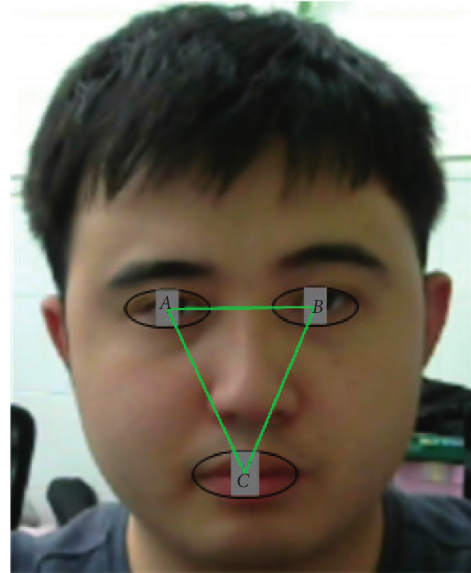
Figure 5: Face Feature Triangle